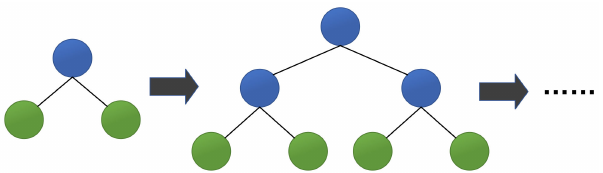
Figure 3. Level-wise tree growth